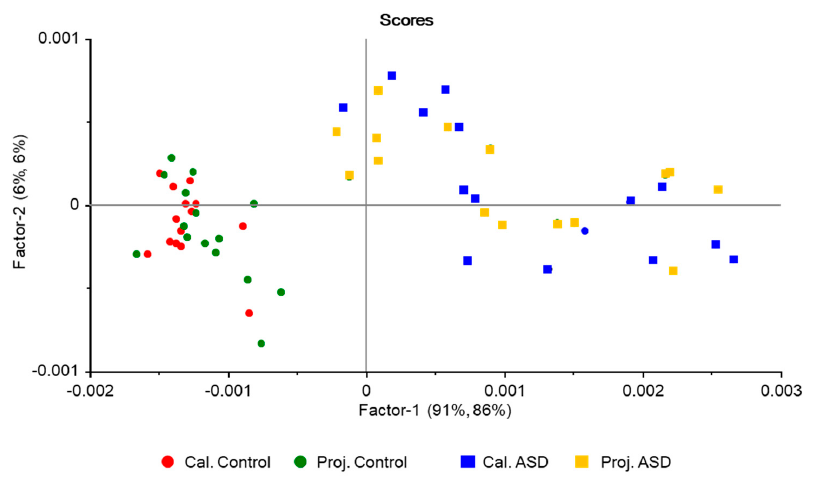
Figure 7. Projection scores plot (Factor-2 vs. Factor-1) for the PLSModel.